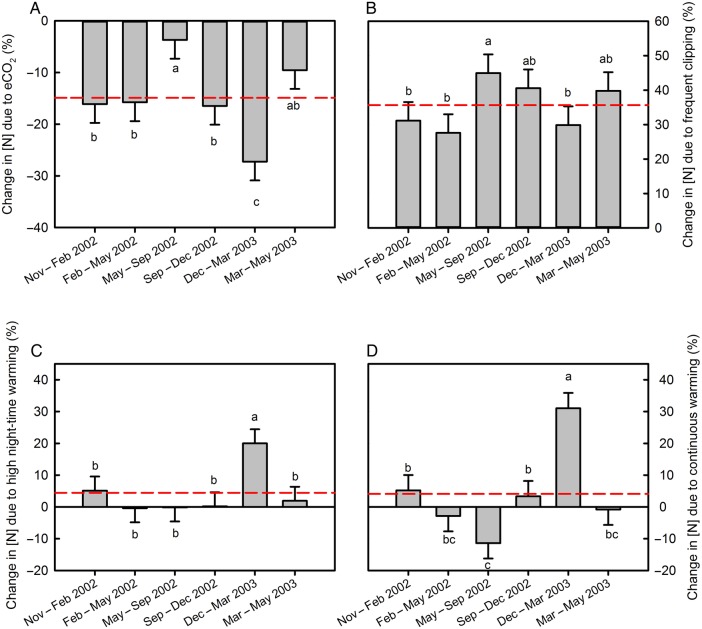
Change in green leaf N concentrations due to (A) increased atmospheric CO2 concentration (756 p.p.m.) compared with ambient atmospheric CO2 concentration (405 p.p.m.), (B) increased clipping frequency, (C) higher night-time warming compared with ambient air temperatures (+2.0/+4.4 °C above ambient, day/night) and (D) continuous warming above ambient (+3.0 °C), as affected by harvest period. The dashed lines indicate the average response to elevated atmospheric CO2 levels (A), increased clipping frequency (B), high night-time warming (C) and continuous warming (D). Data presented are least square means and SEM based on a full model. Different letters indicate statistically significant differences between harvest periods at P < 0.05 using Student's t LSD test.